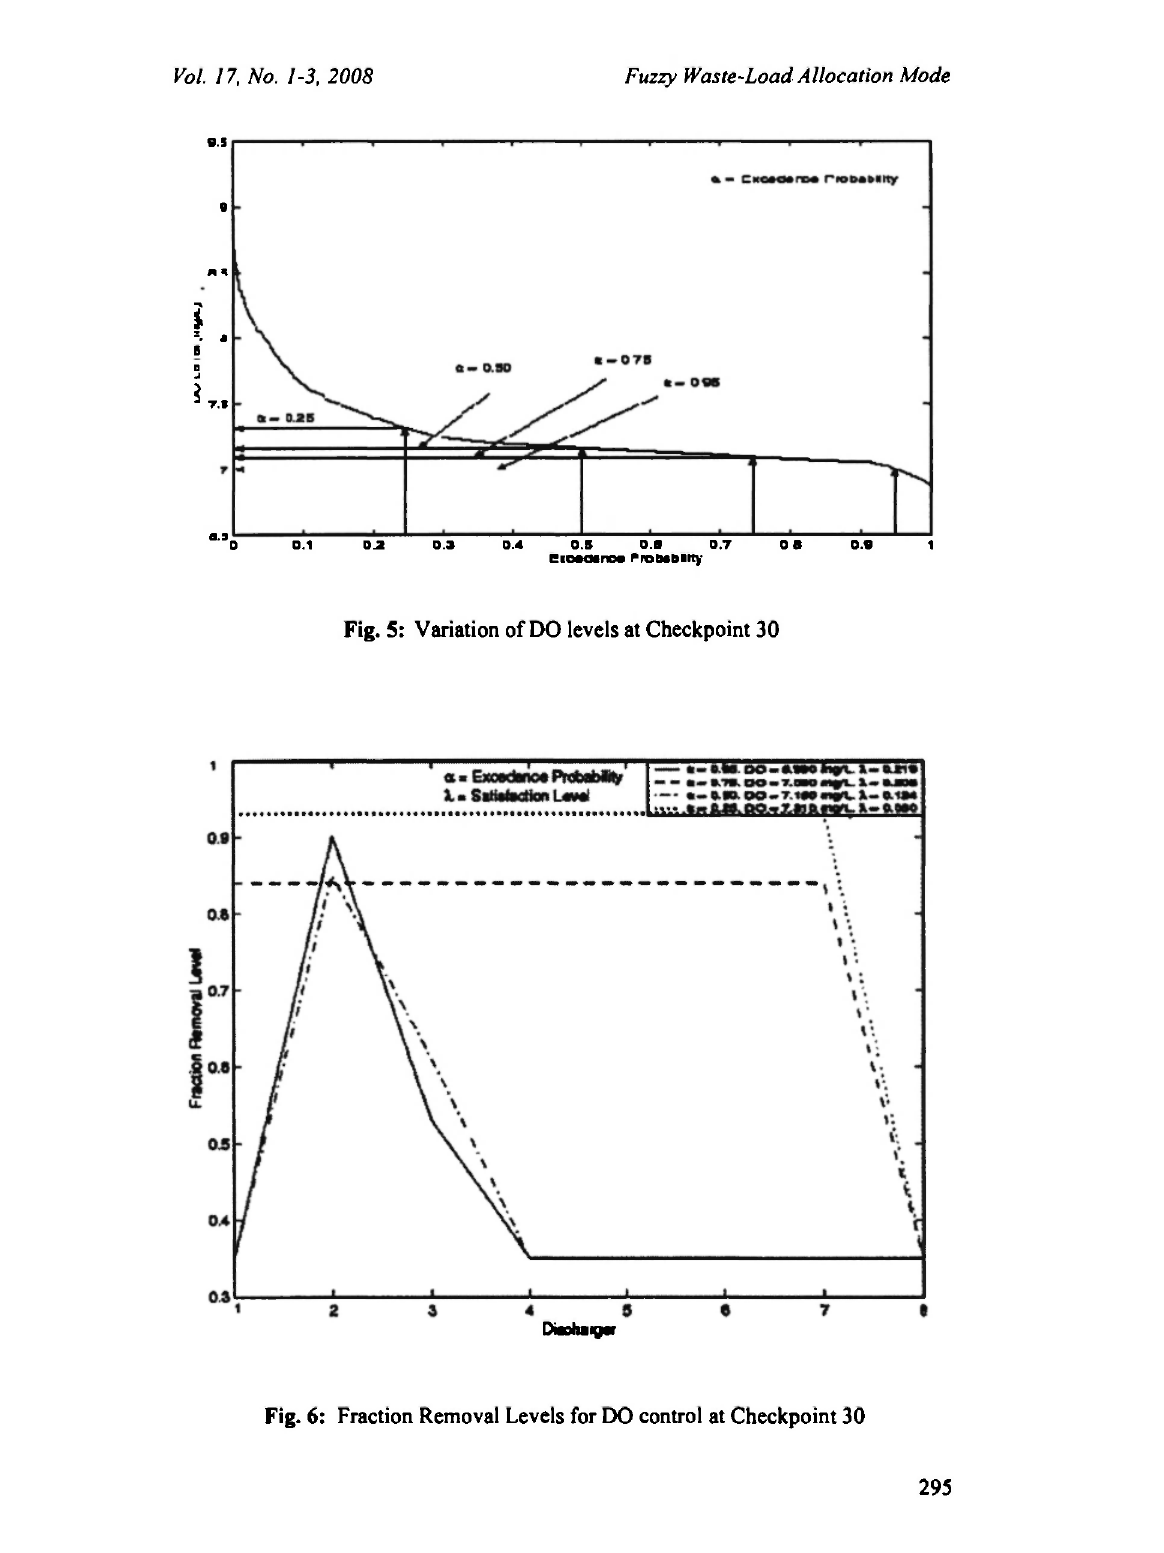
Fig. 6: Fraction Removal Levels for DO control at Checkpoint